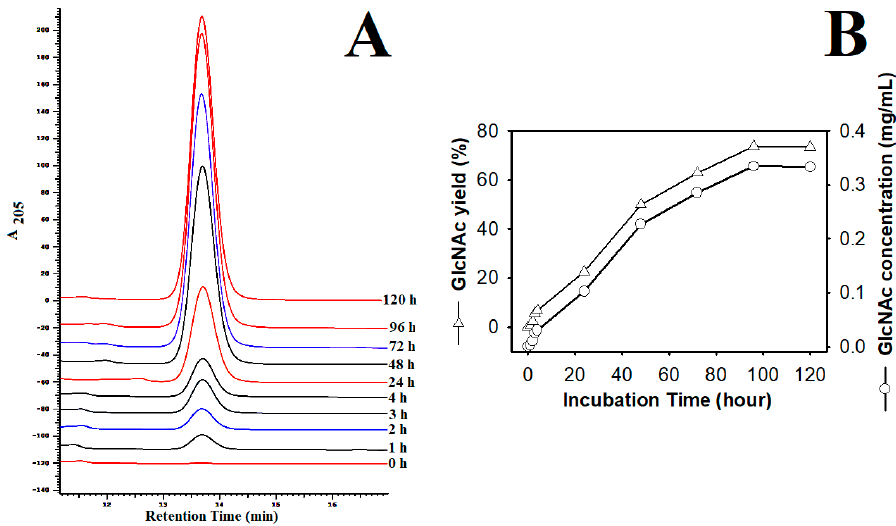
Figure 7. The hydrolysis of β -chitin powder by TKU048 exochitinase: A : HPLC analysis of chitin hydrolysis pattern; B , the time course of the chitin hydrolysis of chitin.